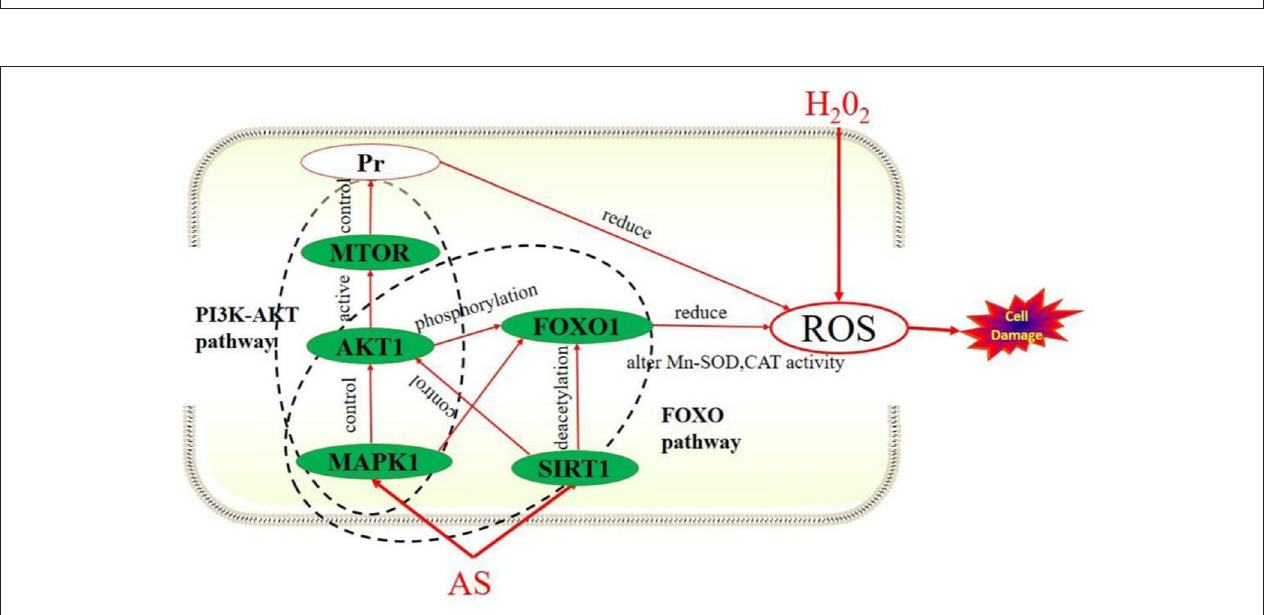
FIGURE 9 | The expression level of core genes. (A) The expression level of AKT1 mRNA. (B) The expression level of MAPK1 mRNA. (C) The expression level of SIRT1 mRNA. (D) The expression level of MTOR mRNA. The results were expressed as the mean ± SE of three independent experiments. * P < 0.05 vs. 0, ** P < 0.01 vs. 0.